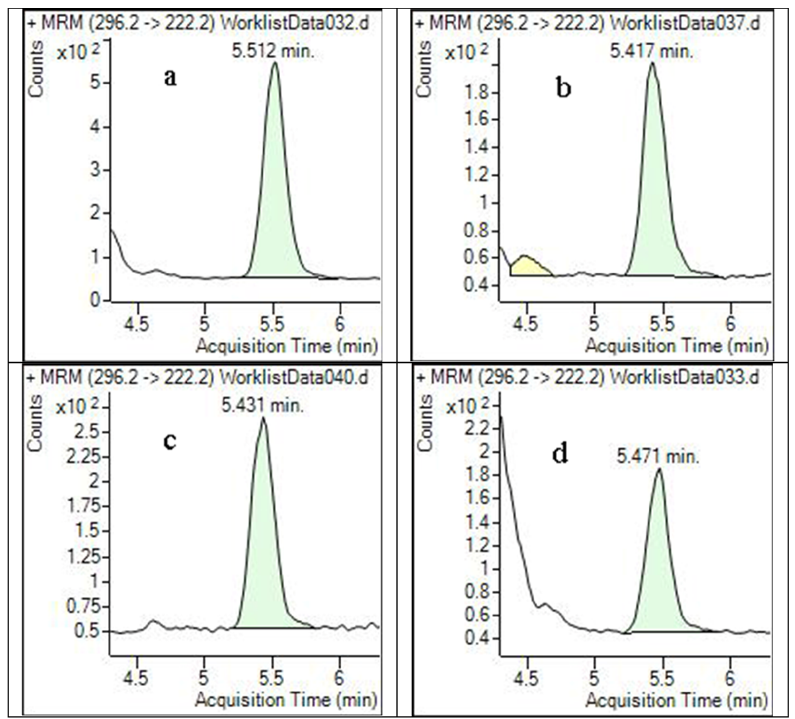
Figure 1. The effects of different mobile phase combinations on the chromatographic peak of bu- tralin. We compared ( a ) methanol and water (0.1% formic acid + 5 mmol ammonium formate), ( b ) methanol and water (0.1% formic acid), ( c ) methanol and water (5 mmol ammonium hydroxide), and ( d ) methanol and